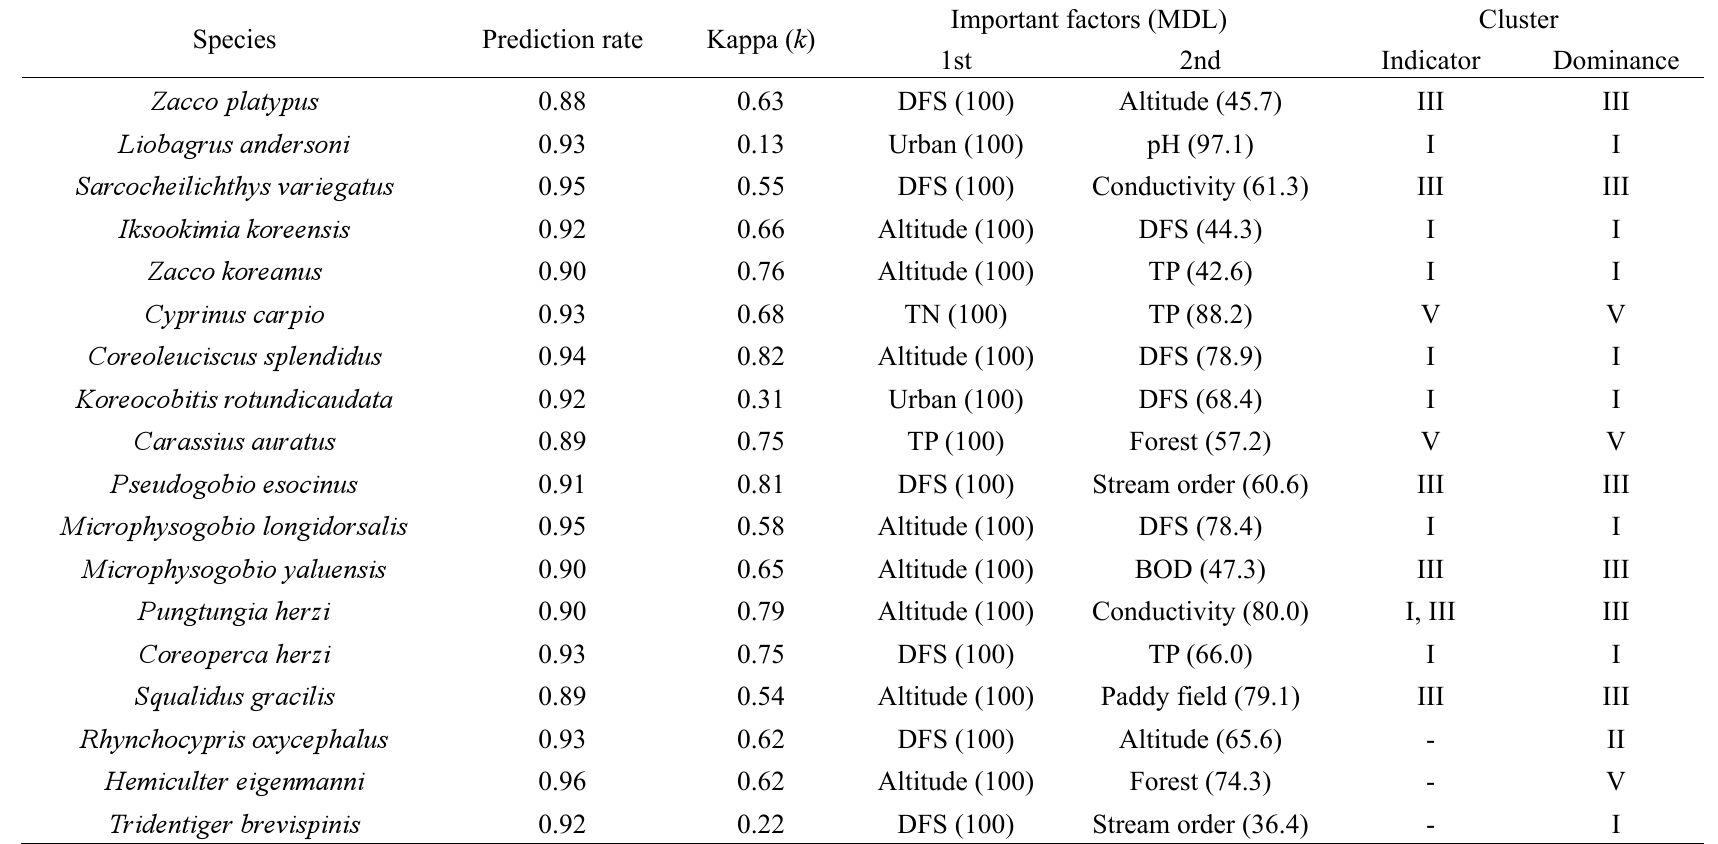
Table 6. Prediction of fish species and evaluation of variable importance using the random forest